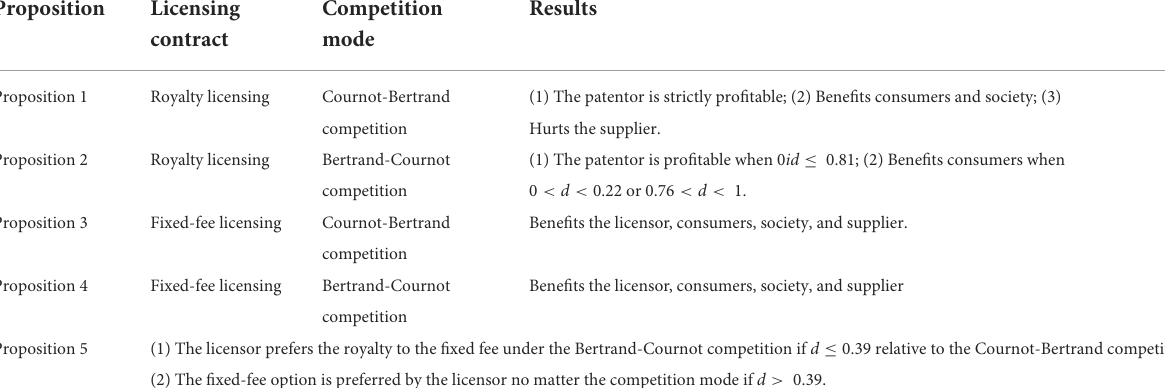
TABLE 1 The summary of